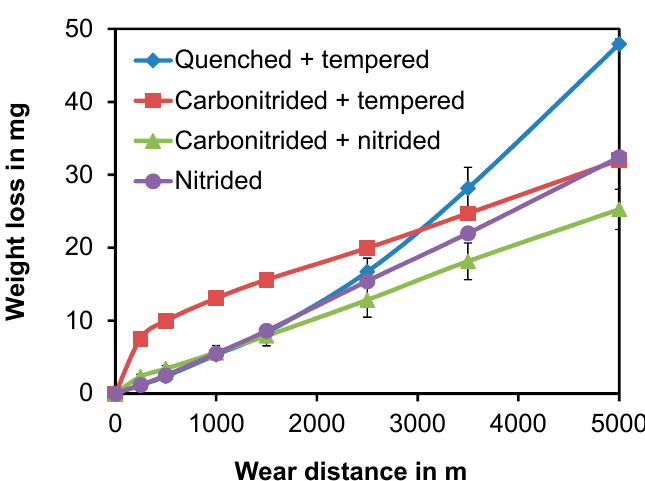
Figure 7. Weight loss of the different heat-treated specimens in the two-disc test dependent on the